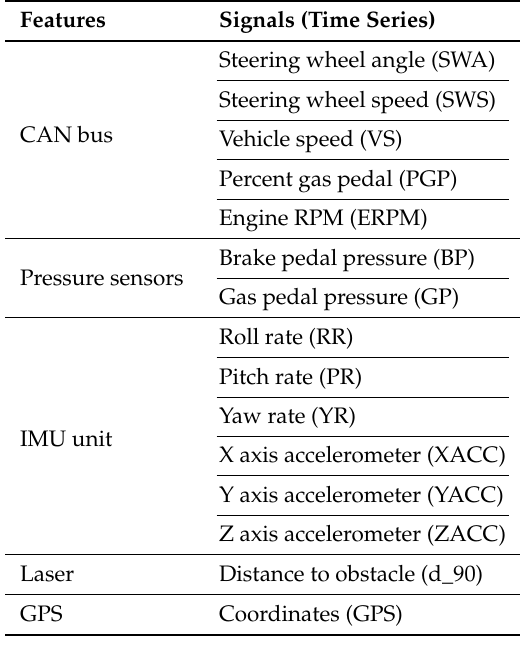
Figure 1. Data-acquisition systems and sensors installed in the Uyanik car [45]. Table 1. Significative variables of the Uyanik dataset